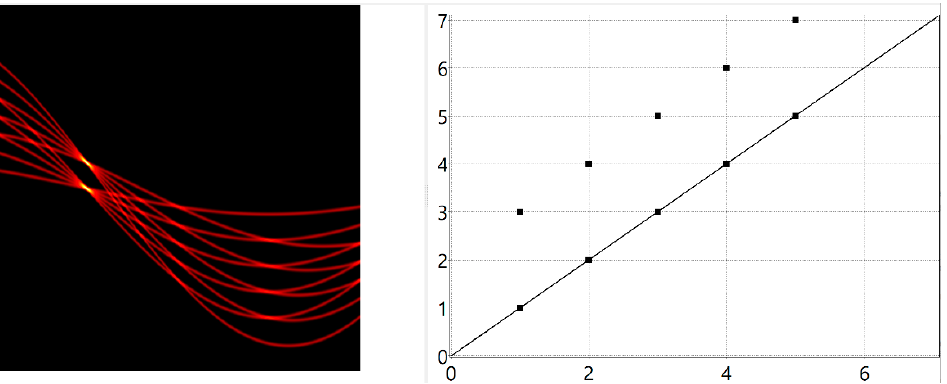
Figure 4. Analysis results of the data sample, σ = 0.1.